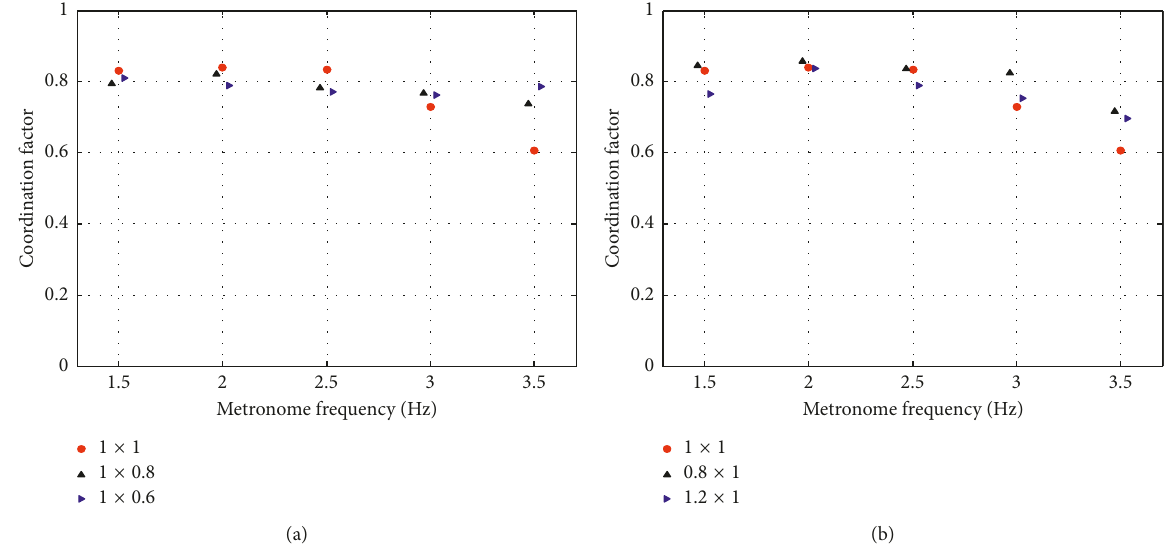
Figure 29: Comparison of coordination factors with three configurations in two groups. (a) Coordination factors in group 01; (b) coordination factors in group